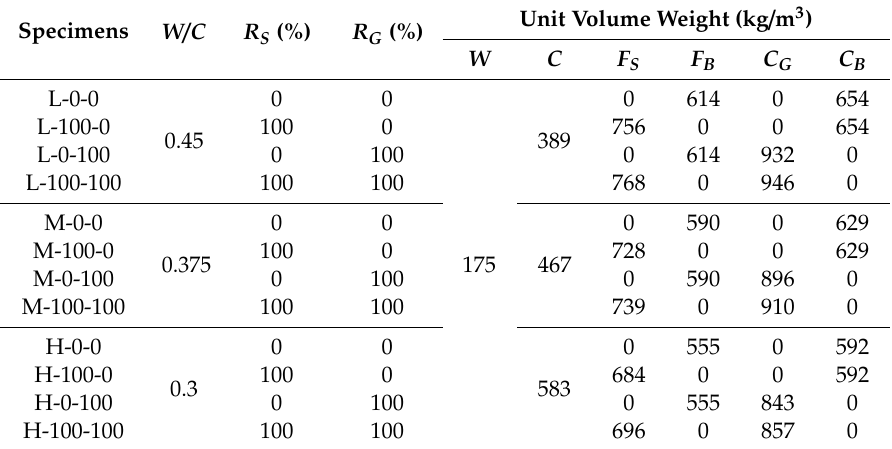
Table 3. Mixture proportions of